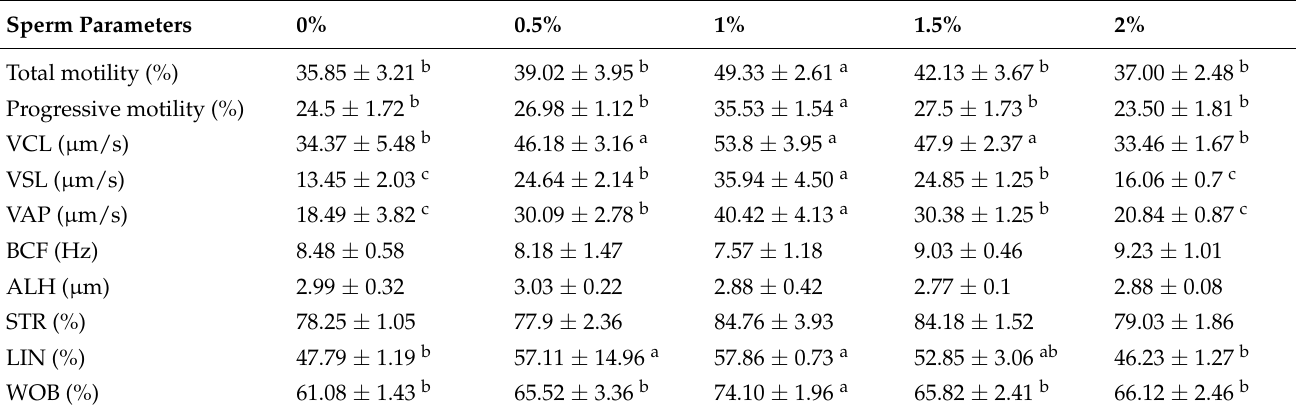
Table 1. Effect of CPLL on post-thaw goat sperm motility parameters measured with